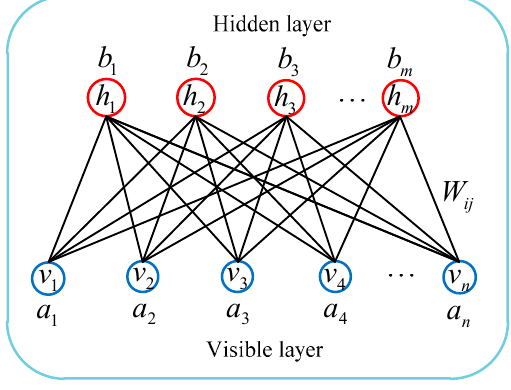
Figure 2. RBM network